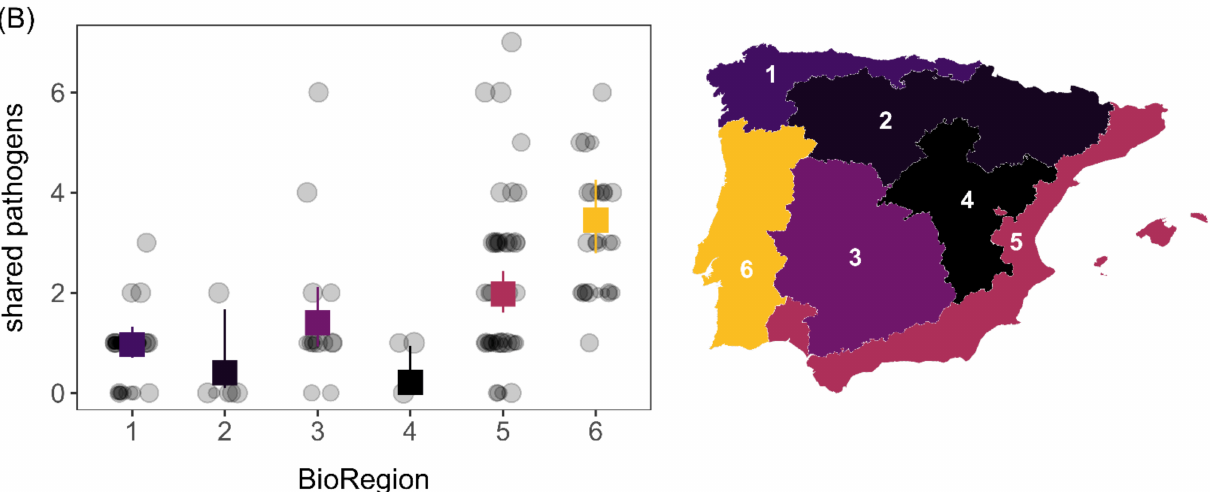
Figure 7. Bioregional patterns of pathogen sharing among Iberian carnivores. ( A ) Nodes in pathogen sharing networks denote host species (abbreviated by their Latin binomial) whereas edges represent two nodes infected by the same pathogen. Networks are stratified by bioregion. ( B ) Modeled relationship (fitted values and 95% confidence intervals from the GAM) between bioregion and pathogen sharing frequency, with raw data overlaid. Maps display GAM-predicted fitted means.